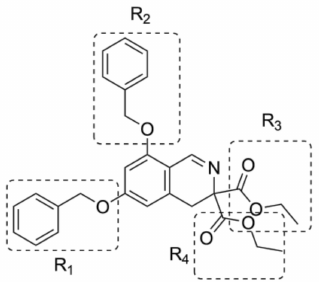
Figure 2. Chemical structure of the starter ligand, diethyl 6,8-dibenzyloxy-3,4-dihydroiso- quinoline- 3,3-dicarboxylate, with selected substituents for